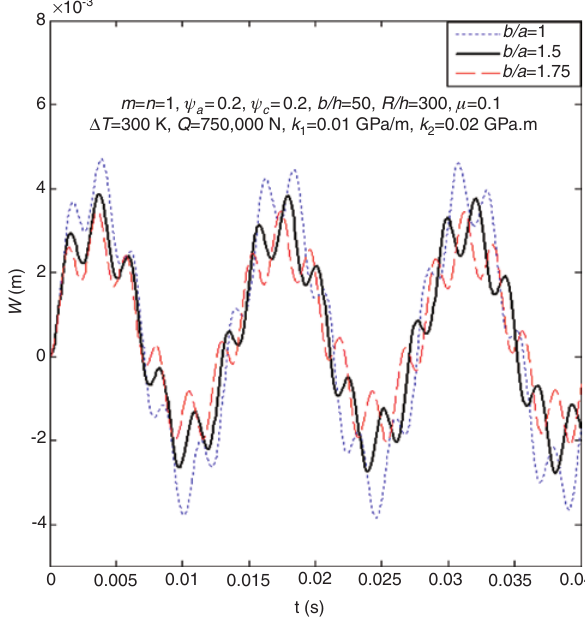
on the dynamic c Figure 4: Effect of the b / a ratio on the non-linear dynamic response of the polymer composite cylindrical panel.